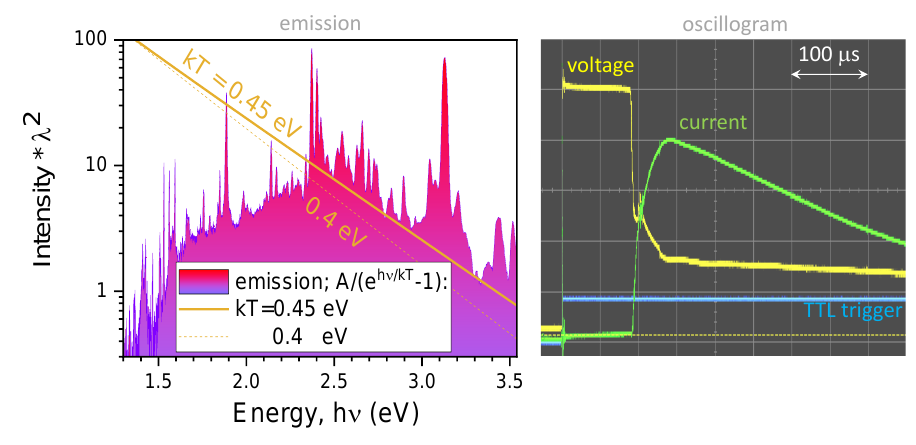
Figure A1. Si µ -thermite (bridge). Estimation of the black body radiation temperature, T , from the linearised log-lin emission intensity, I , plot I λ 2 ∝ h ν , where ν is the photon energy ν = c / λ . The ) − 1 ] function, here A is a fitting amplitude which black-body radiation is modeled with A / [ exp ( h ν kT adjust the vertical shift of the fit-line. The best fit is achieved at kT = 0.45 eV or T = 5220 K (the dashed line is for the 580 K lower temperature). Right panel shows the oscilloscope transients for the voltage U = 250 V and